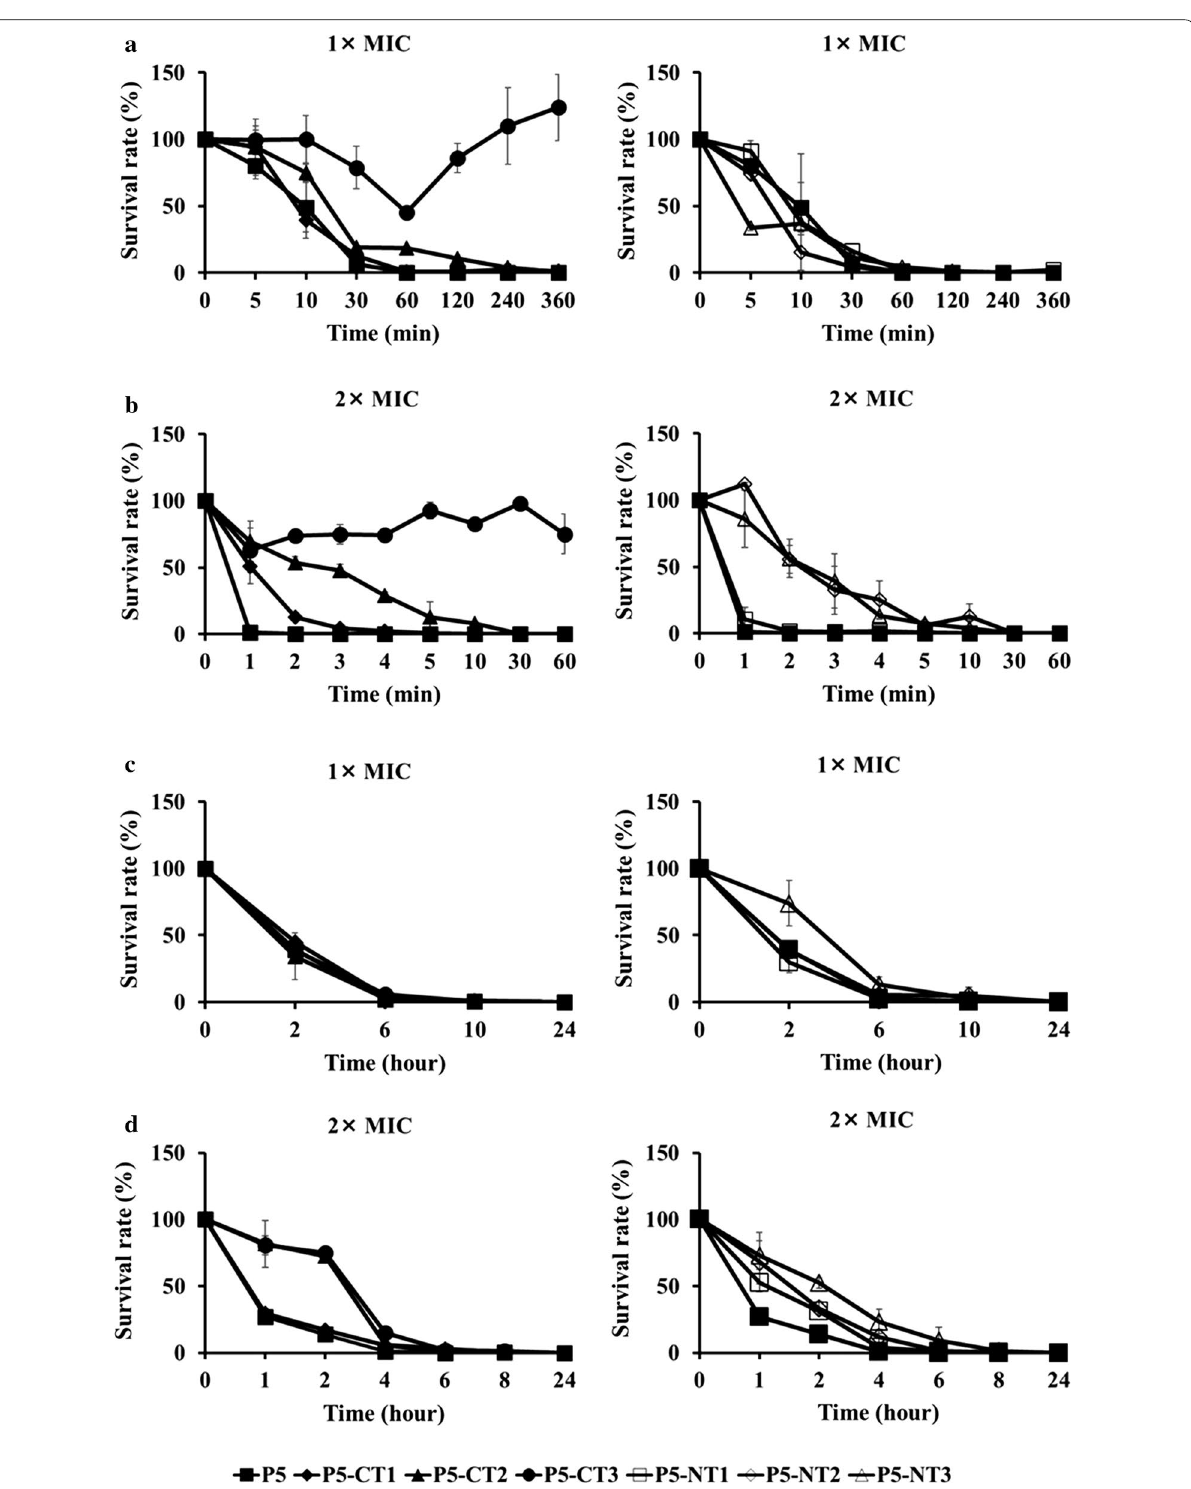
Fig. 2 Time-kill kinetic curves of the peptides. Bactericidal kinetics of P5 and its analog peptides were assessed at aeruginosa ATCC 27853 and c , d S. aureus ATCC 25923. MIC minimum inhibitory concentration, CT C-terminus, NT